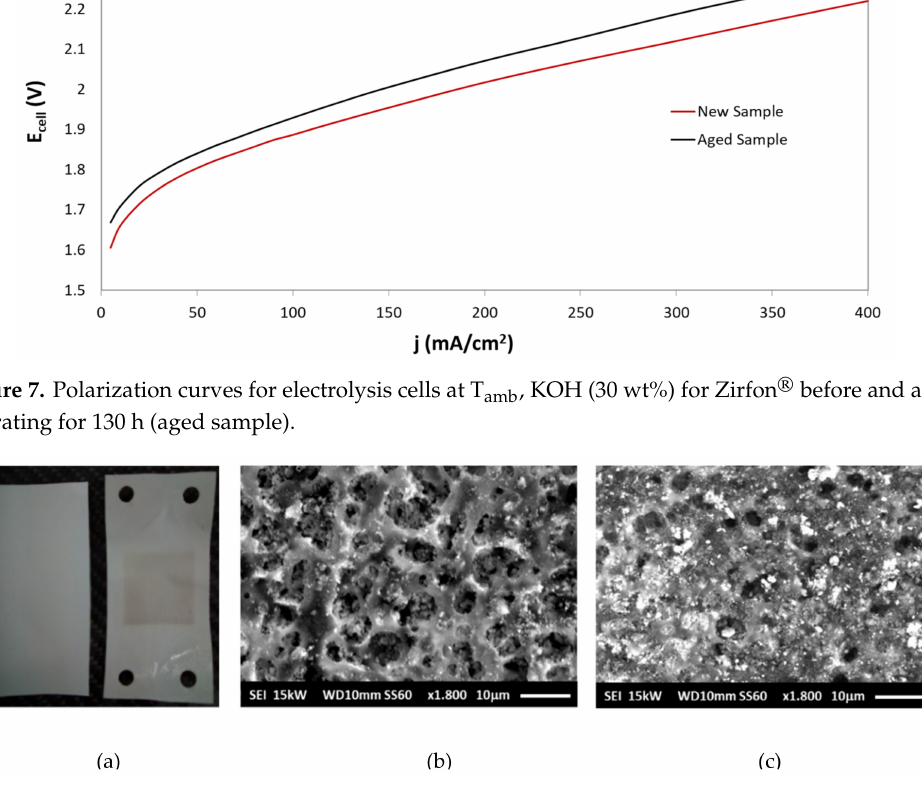
Figure 8. Picture of a new (( a )- left side), and 130h aged Zirfon ® sample (( a ) – right side). SEM images for new ( b ), and 130 h aged ( c ) Zirfon ®